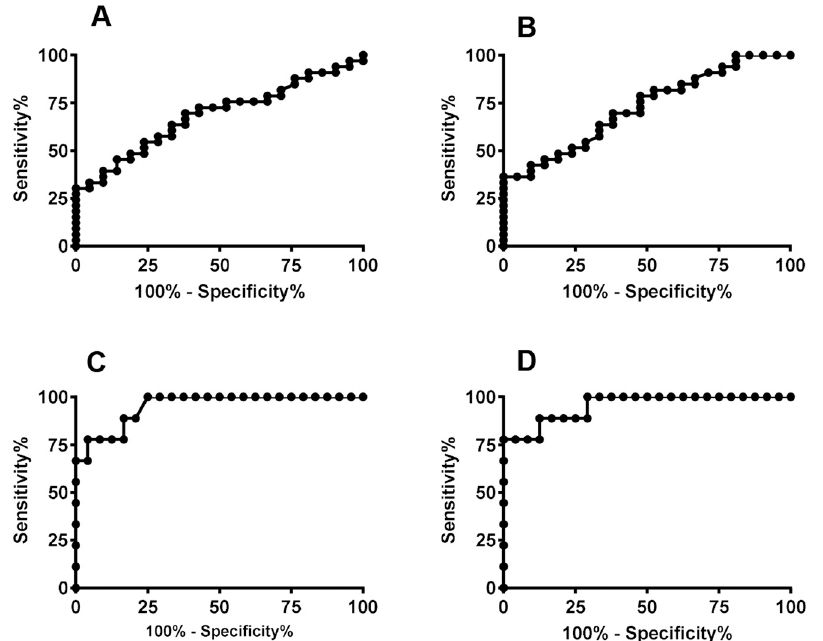
Figure 3: ROC curve for serum neopterin on day 8 and 14 as biomarker in prediction acute pancreatitis severity and